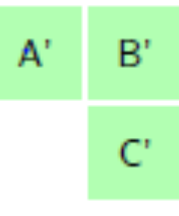
Figure 16. Square tiling in small complex with starting point at the centre cell after